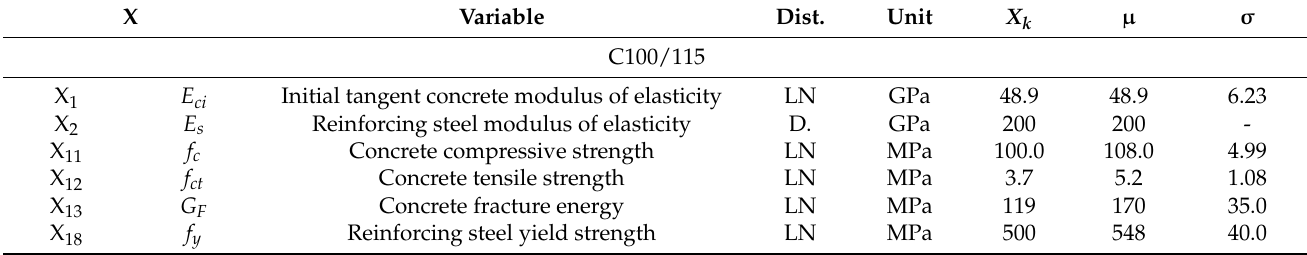
Table 4. Input parameters for the probabilistic analyses of the EN 1992-1 Non-Linear Finite Element provisions of the slender column made of C100/115 (details regarding C45/55 are provided in Table 3).